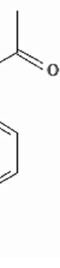
Figure 3. Chemical structure of acetaminophen, as adapted from